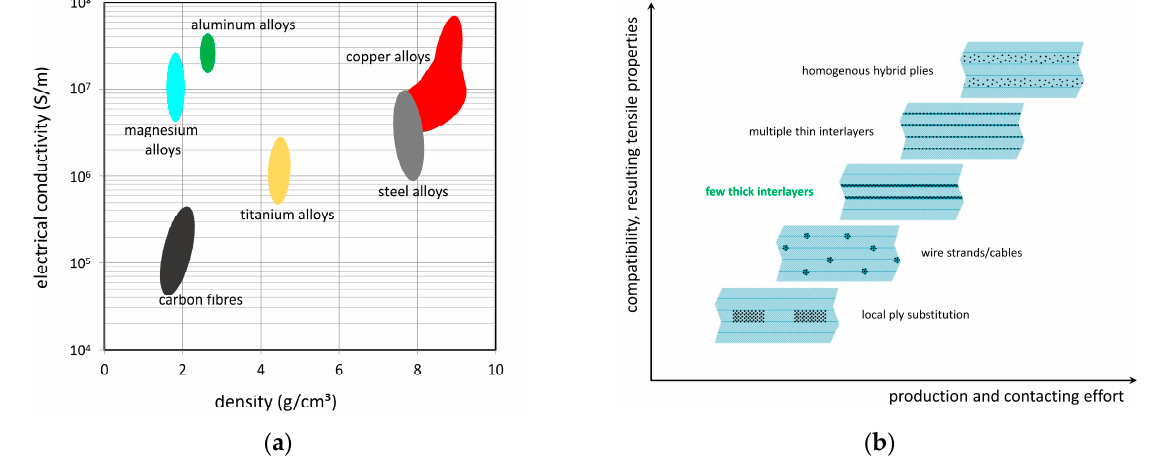
Figure 2. ( a ) Electrical conductivities and densities of carbon and metal fiber candidates [28,29]; ( b ) different approaches to metal fiber integration. Table 1. Typical mechanical and electrical properties of aluminum (pure/alloys), E-glass and epoxy matrix